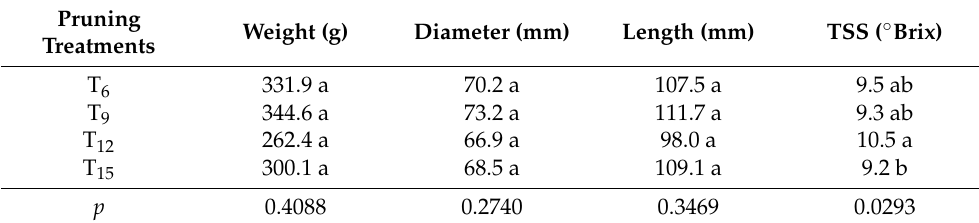
Table 2. Fruit size and soluble solid content in response to pruning